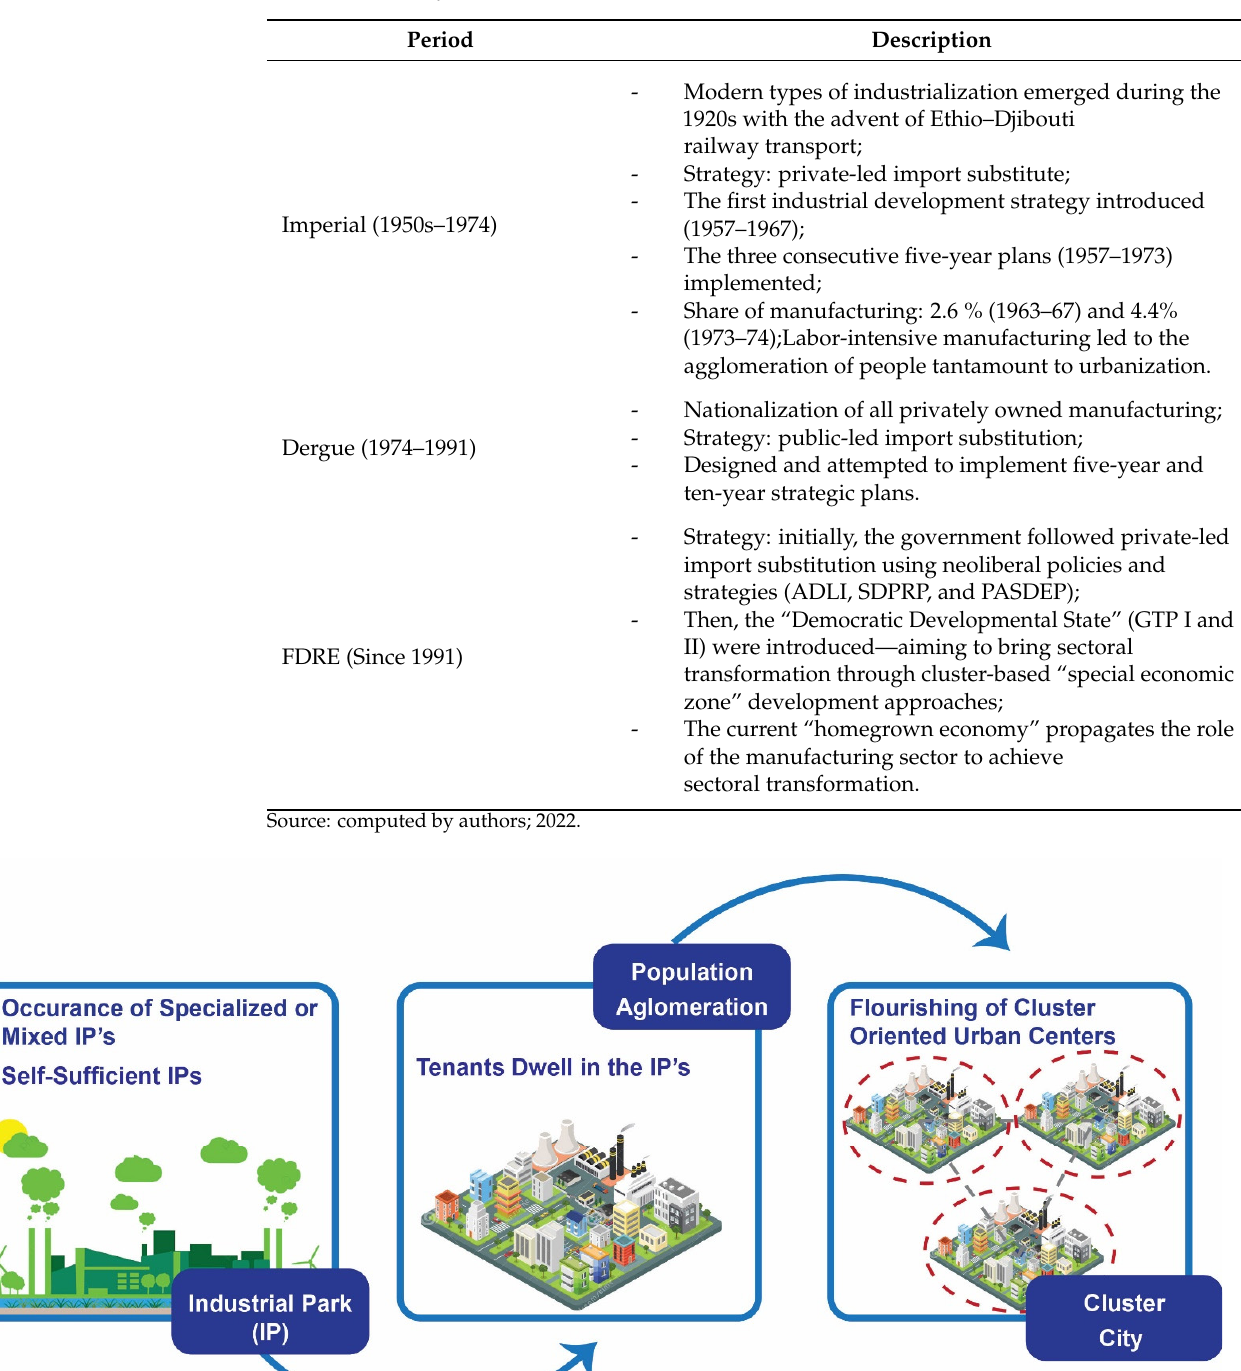
Table 2. Summary of industrialization and urbanization in time horizon.